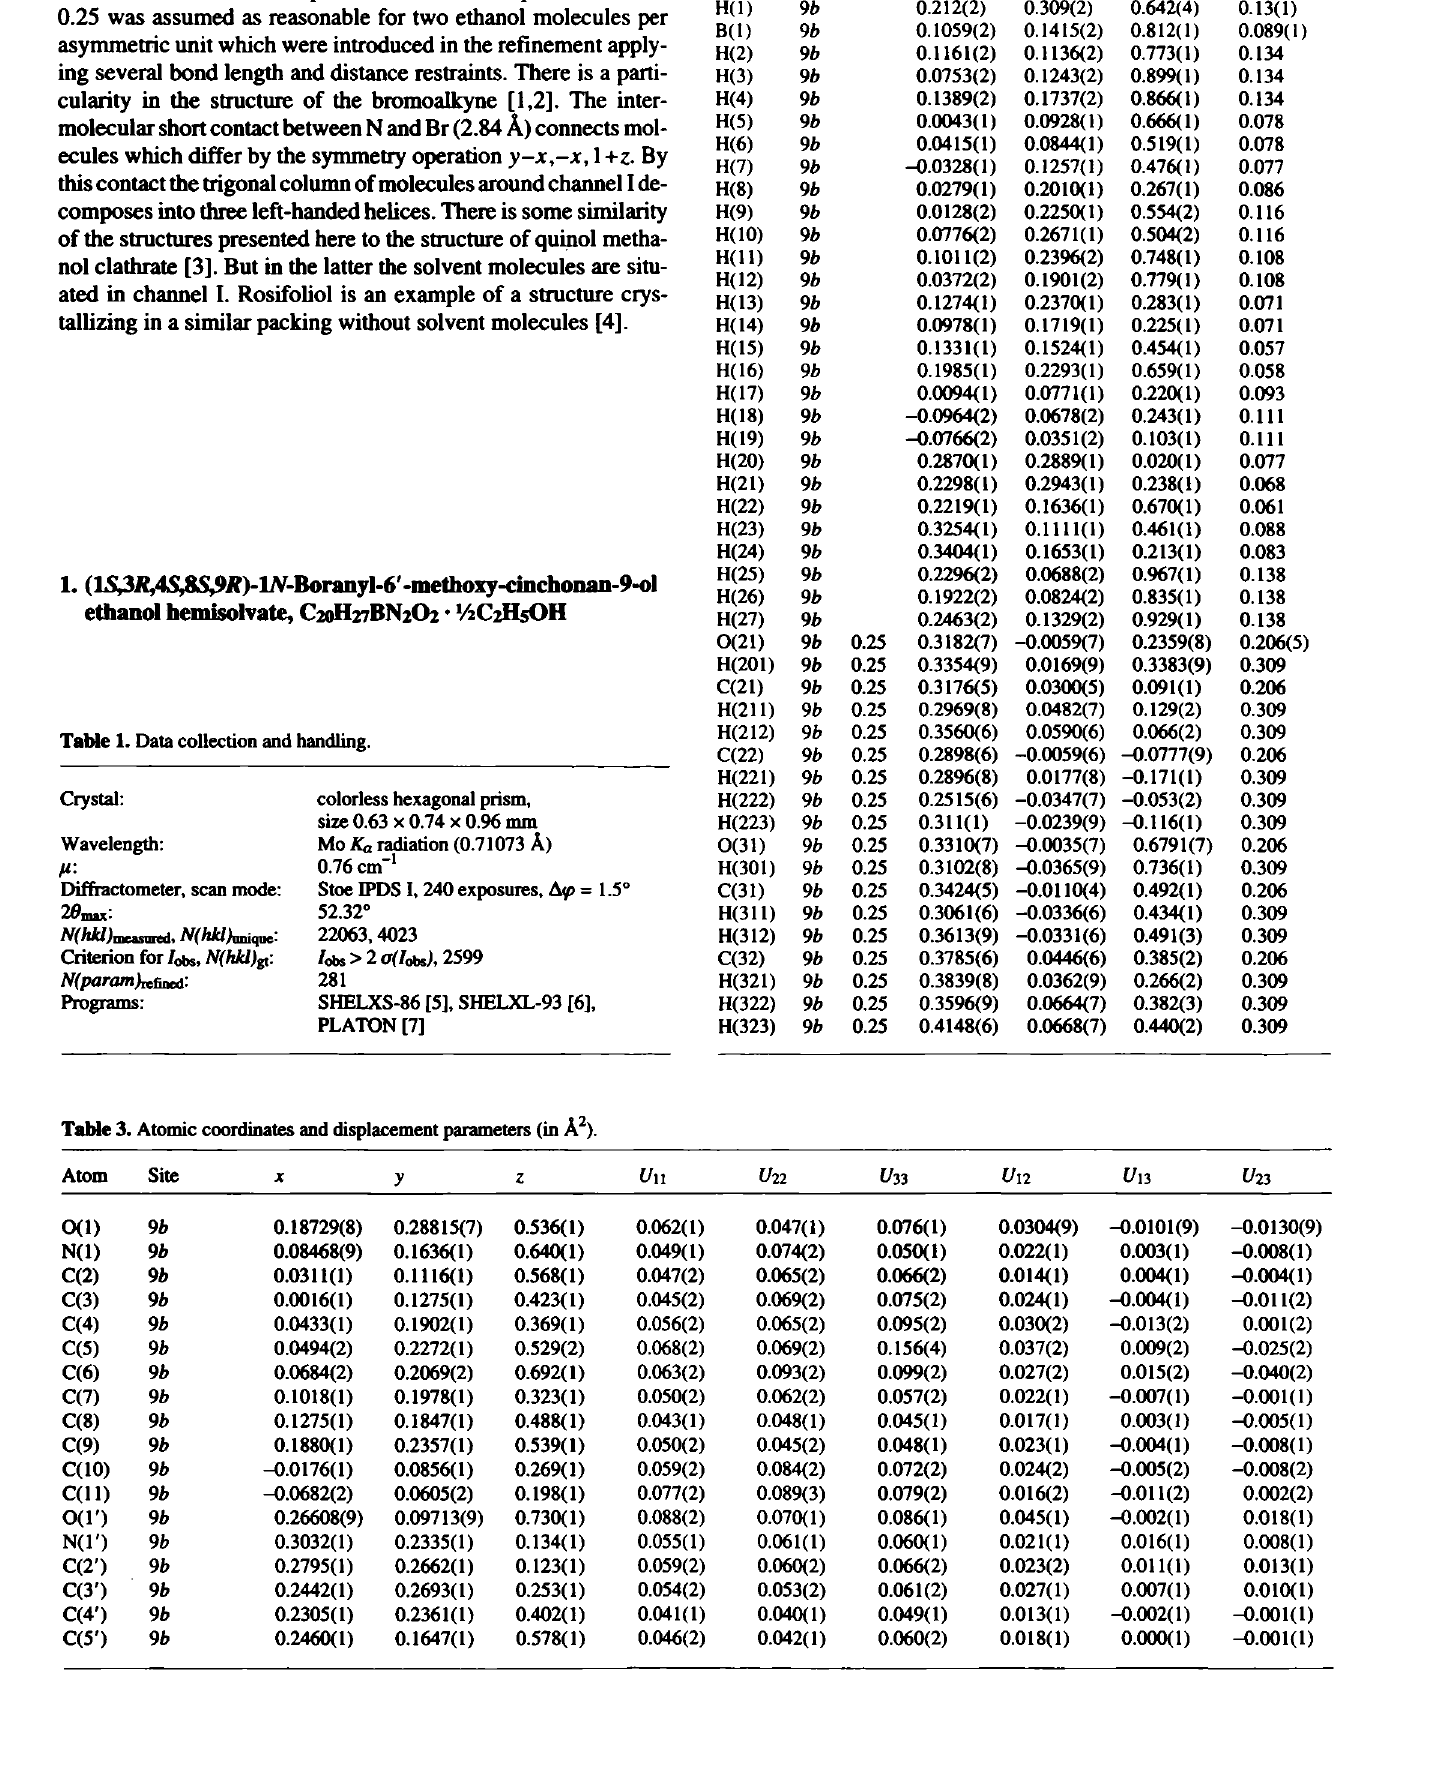
Table 2. Atomic coordinates and displacement parameters (in Ä 2 ).